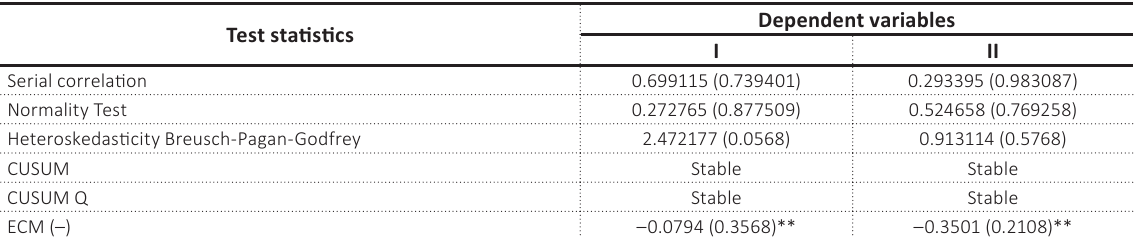
Table 8. Diagnostic and stability tests for models I and